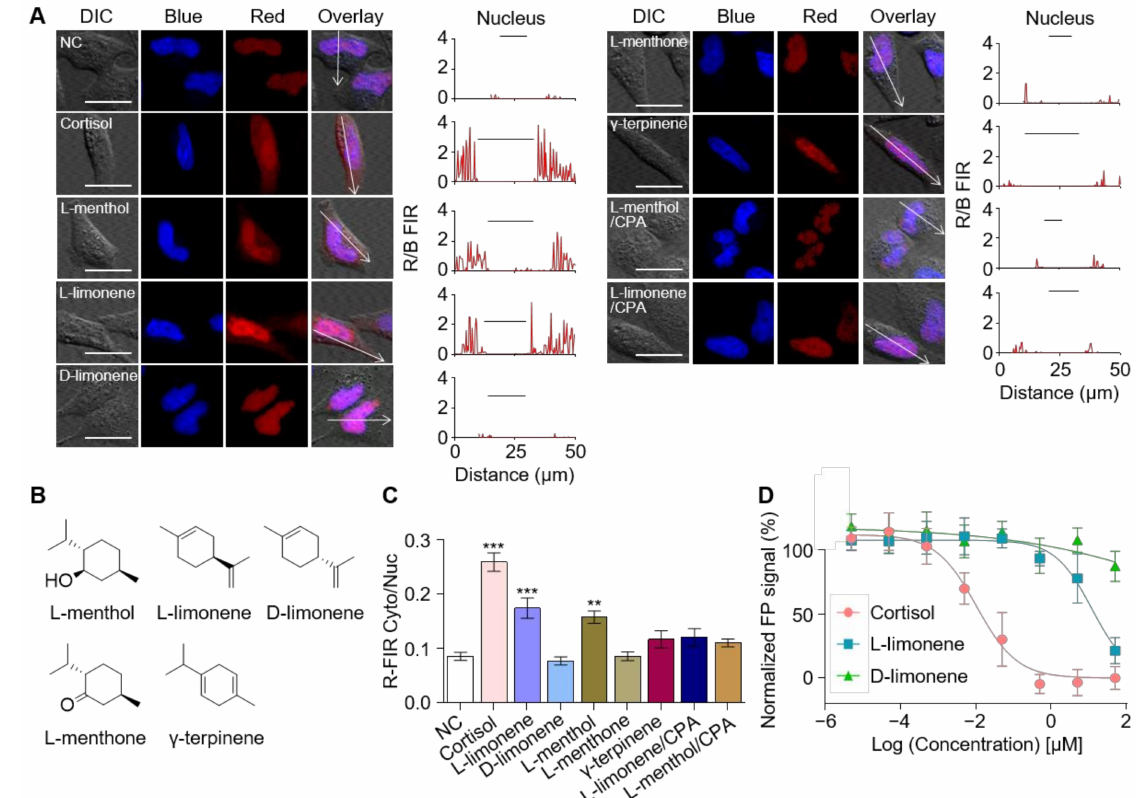
Figure 5. Identification of GR effectors from the components of peppermint oil extracts using sensor cells. ( A ) The sensor cells responded to L-limonene and L-menthol, whose signals are repressed on co-treatment with CPA (scale bar = 25 µ m); ( B ) the structures of the major components of peppermint oil, i.e., L-limonene, L-menthol, L-menthone, and γ -terpinene are prominent components of peppermint oil. D-limonene is an enantiomer of L-limonene; ( C ) the R-FIR Cyto/Nuc ratios are calculated (** p < 0.01 and *** p < 0.001); ( D ) In vitro interaction between GR and L-limonene was studied using a competitive GR binding assay based on fluorescence